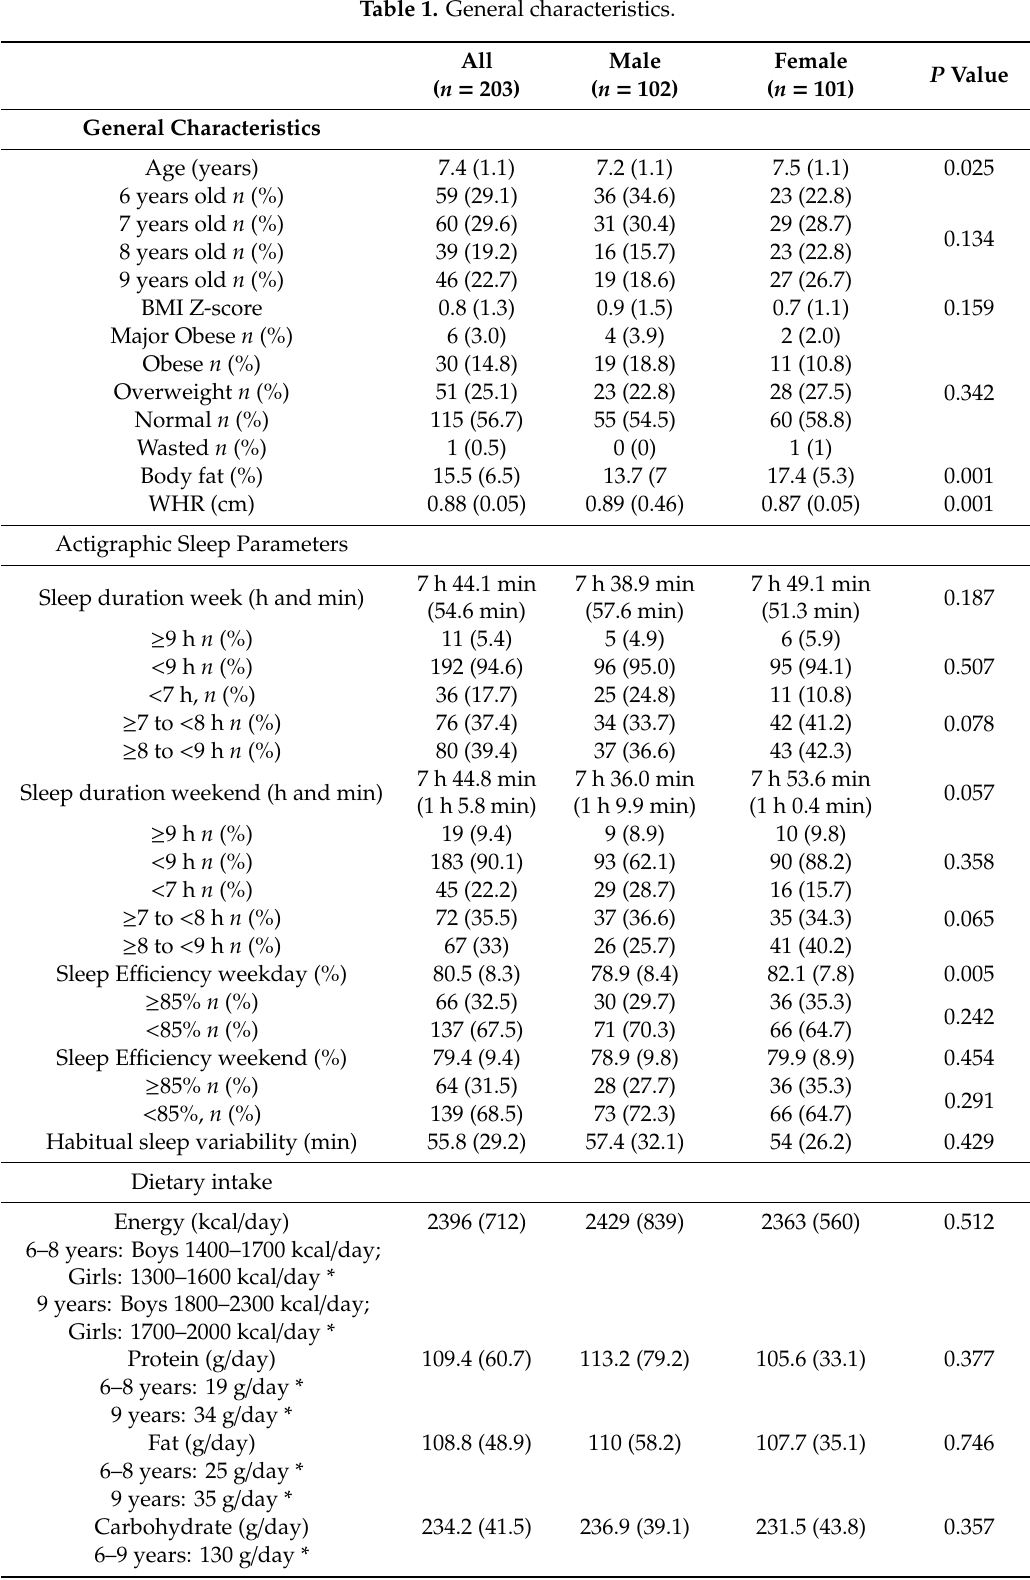
Table 1. General